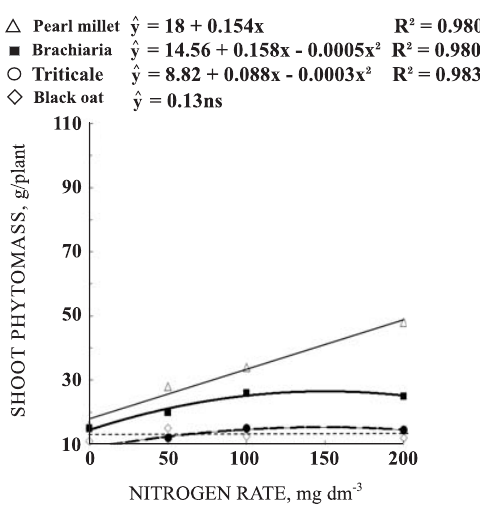
Figure 1. Shoot dry matter of cover grasses as related to N fertilization, 54 days after sowing. Vertical bar show the LSD comparing species (p ≥≥≥≥≥ 0.05).